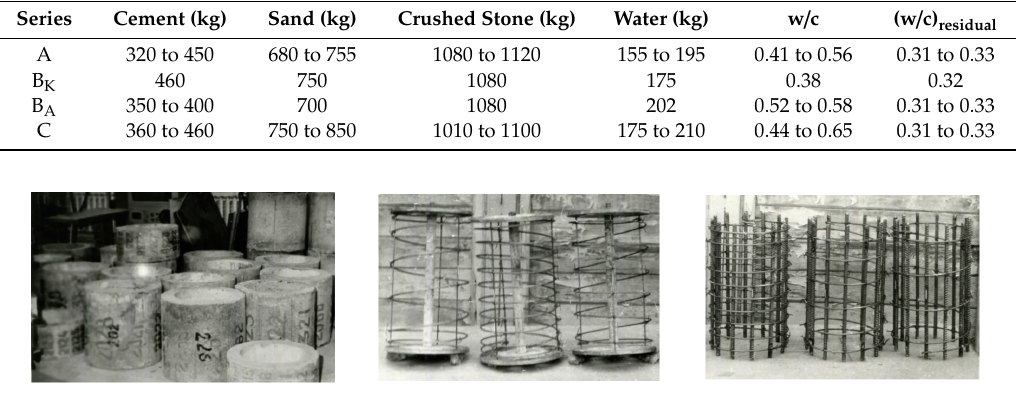
Table 1. Composition of concrete mixture for 1 m 3 . 126